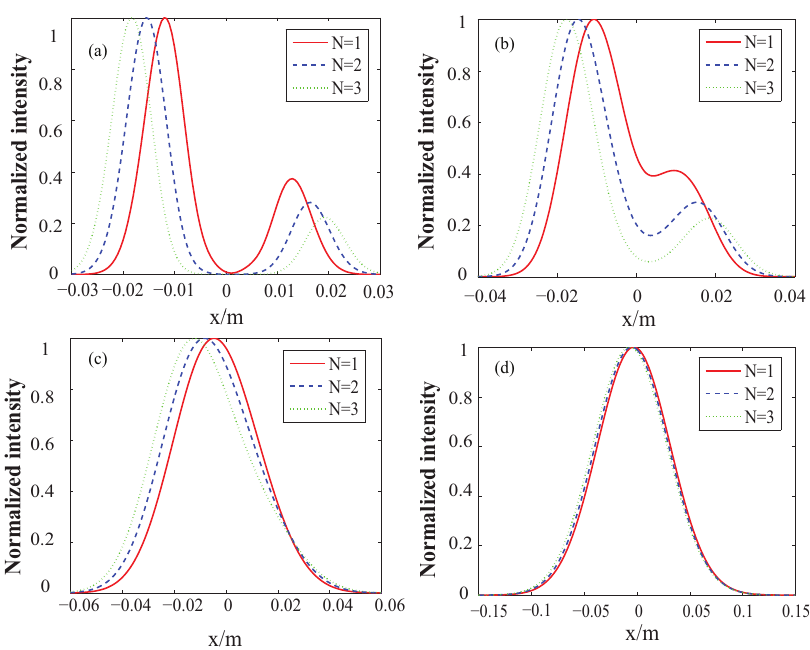
Figure 4. Cross lines ( y = 0) of the normalized average intensity of the OAHGSM vortex beam passing through anisotropic oceanic turbulence with different hollow order N at z = 100 m ( a ), z = 300 m ( b ), z = 600 m ( c ), and z = 1200 m ( d